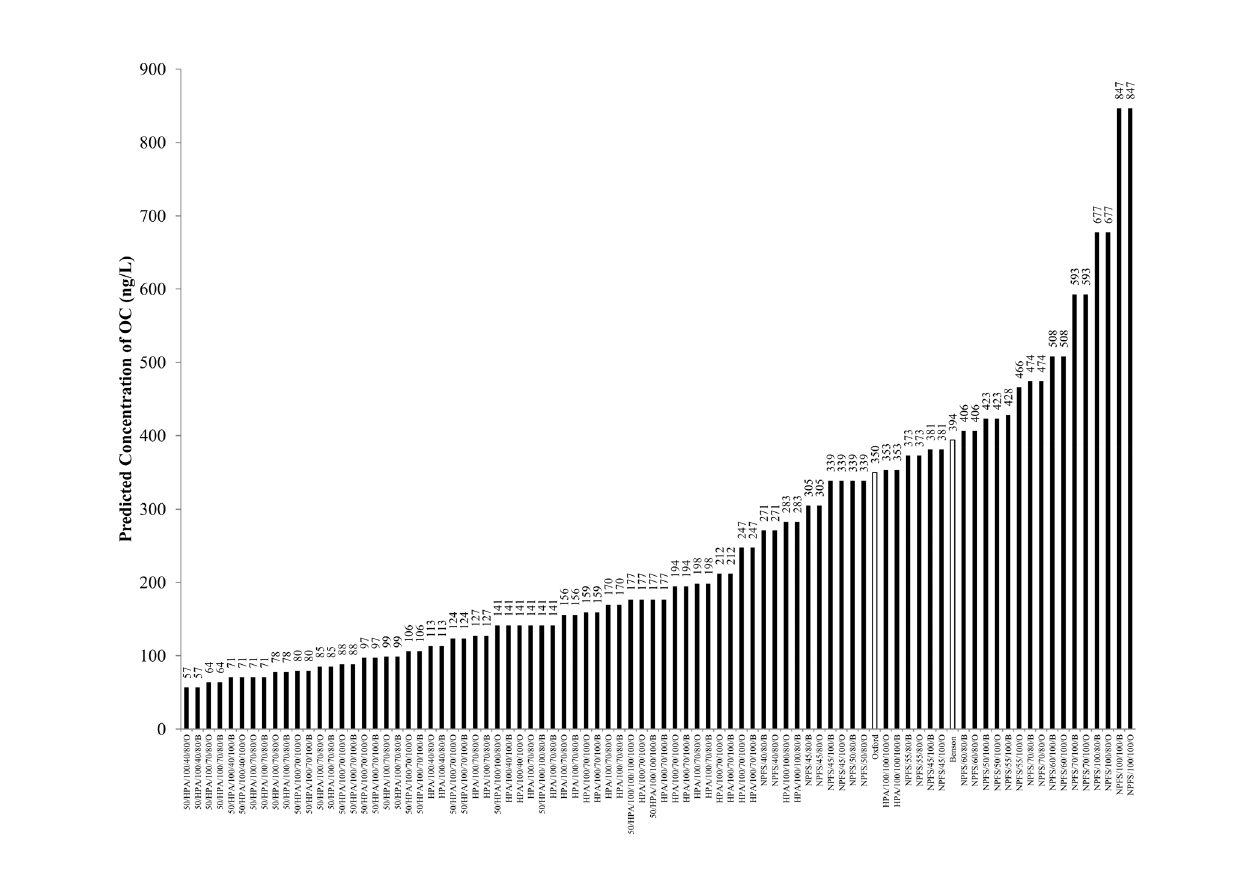
Figure 5. Scenario predictions of OC influent concentration (ng/L). Scenario codes can be interpreted as follows: percent of ILI cases prescribed OC, used only when HPA data was employed (assumed =100, unless specified as 50) / Source of data (NPFS or HPA)/percent compliance (40, 45, 50, 55, 60, 70, 100%) / percent of parent compound converted to OC before WWTP inlet (80, 100%) / O= Oxford WWTP and B = Benson WWTP. Mean 24-h OC concentrations at Benson and Oxford are noted by the WWTP name, only. Daily water usage was assumed to be the UK national average of 230 L/capita [3].